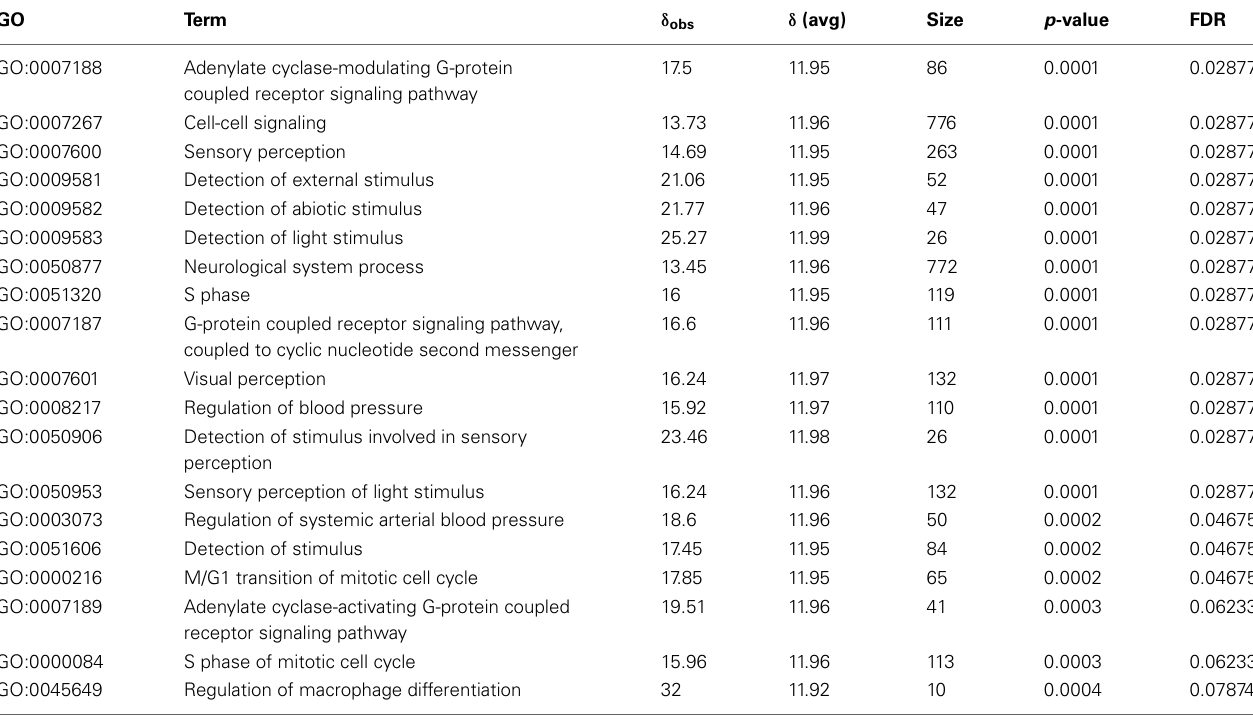
Table 4 | Results for the degree centrality pathway analysis test for the BC3Net